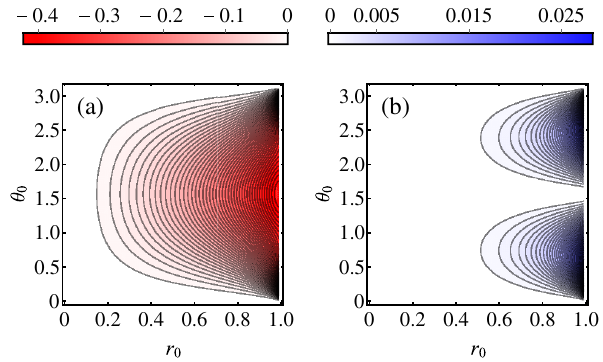
FIG. 4. Contour plot of the difference Δ δ γ ≡ δ QF γ − δ WY γ be- tween the tightness parameter corresponding to the quantum Fisher information metric and the one corresponding to the Wigner-Yanase information metric, for the parallel dephasing process as a function of r 0 and θ 0 , for (a) Γ τ ¼ 10 , ω 0 ¼ 10 and (b) Γ τ ¼ 10 , ω 0 ¼ 0 . 1 . The QSL constructed with the Wigner- Yanase skew information is tighter than (respectively, looser than) the one constructed with the quantum Fisher information when Δ δ 0 (resp. Δ δ 0 ), as in panel (b) [resp. γ > γ <